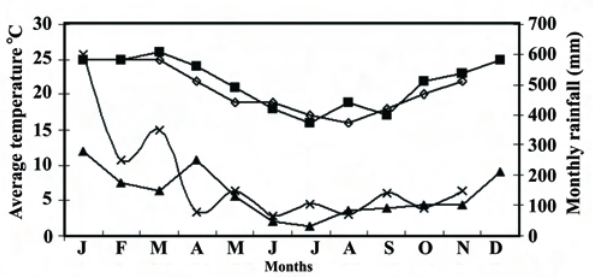
Fig. 1. Monthly rainfall for 2002 (x) and 2003 (filled triangles) in the study region, and average temperature in 2002 (filled squares) and 2003 (open squares). Source: